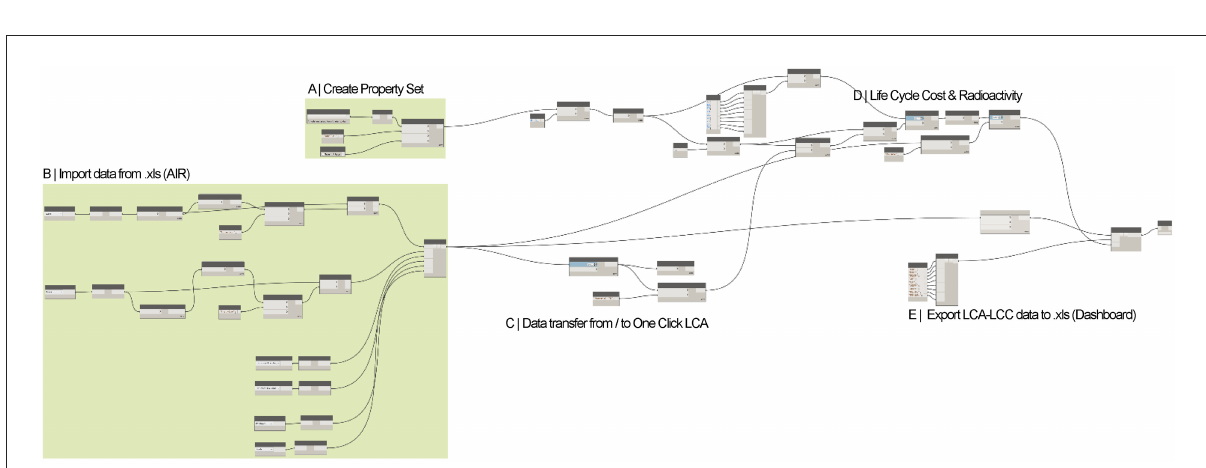
FIGURE2 Screenshot of the main blocks of the code created with the visual programming tool Dynamo.